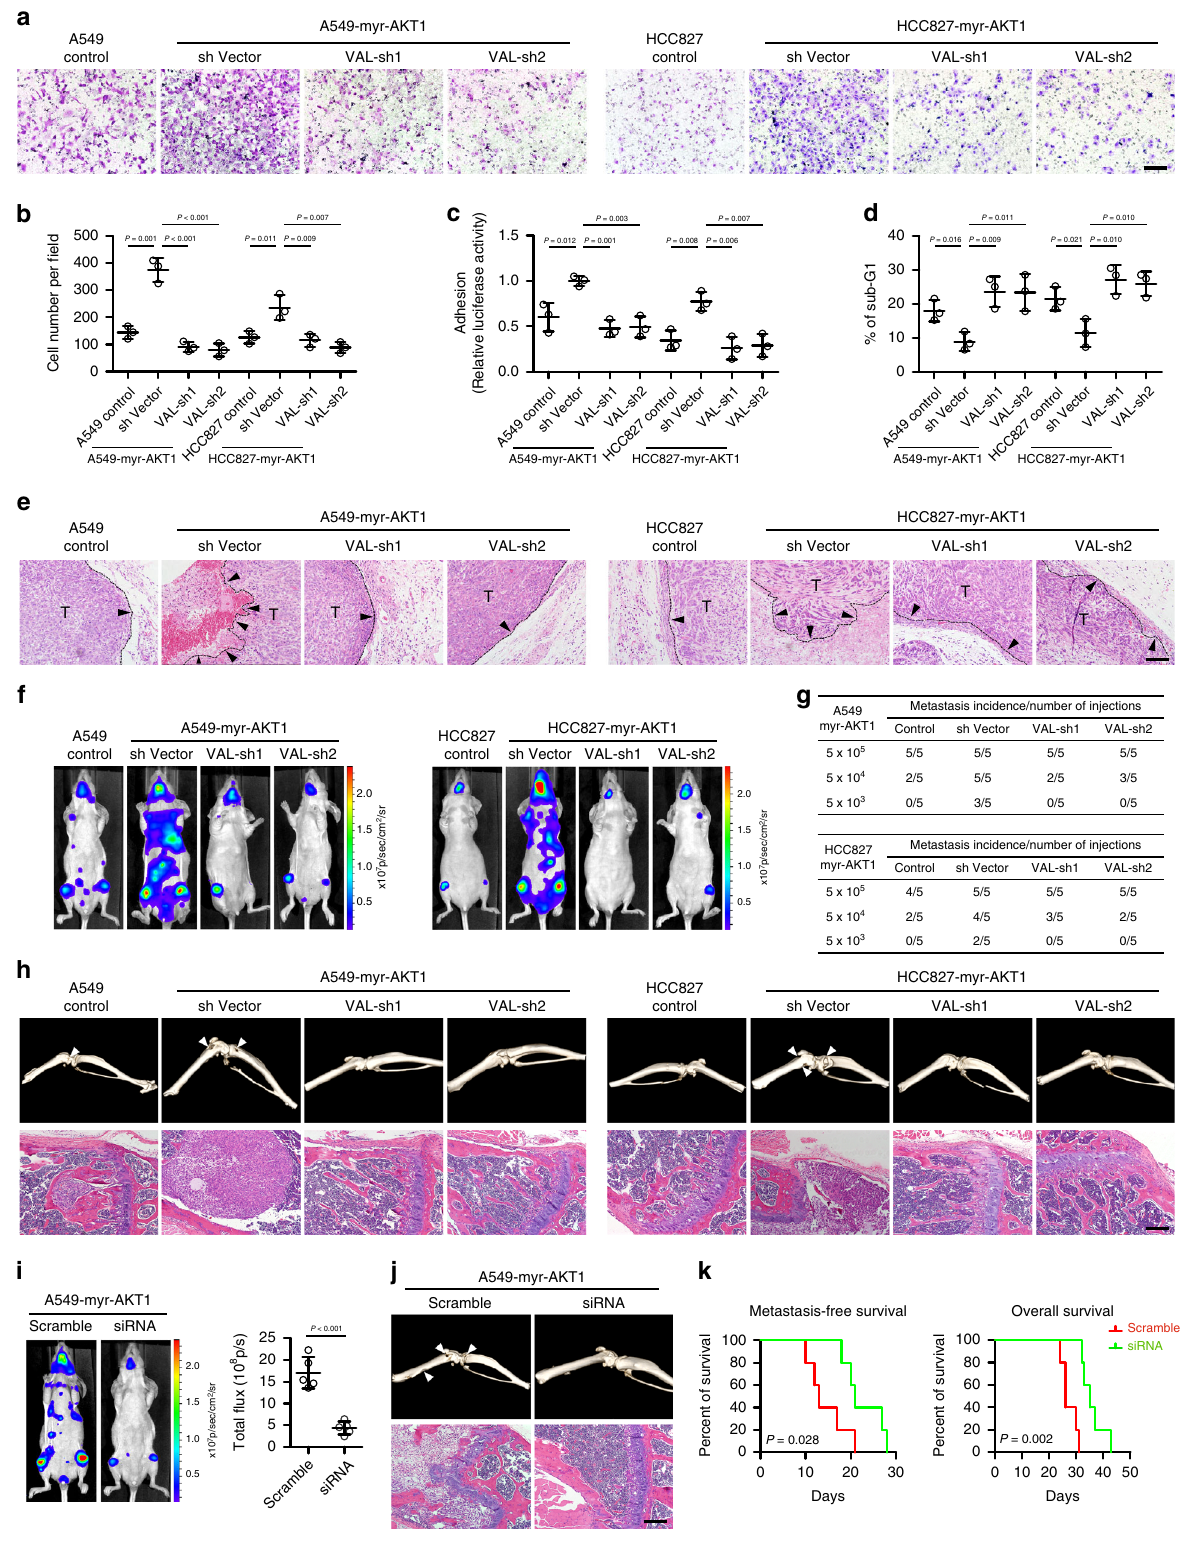
FGF2 treatment faintly decreased polyubiquitination of Vimentin protein and thus marginally increased Vimentin protein levels (Supplementary Fig. 5g, h), indicating an importance of VAL induced by fully activated AKT/STAT3 signaling in the process of Vimentin upregulation. Taken together, these data suggest that the binding of VAL to Vimentin proteins